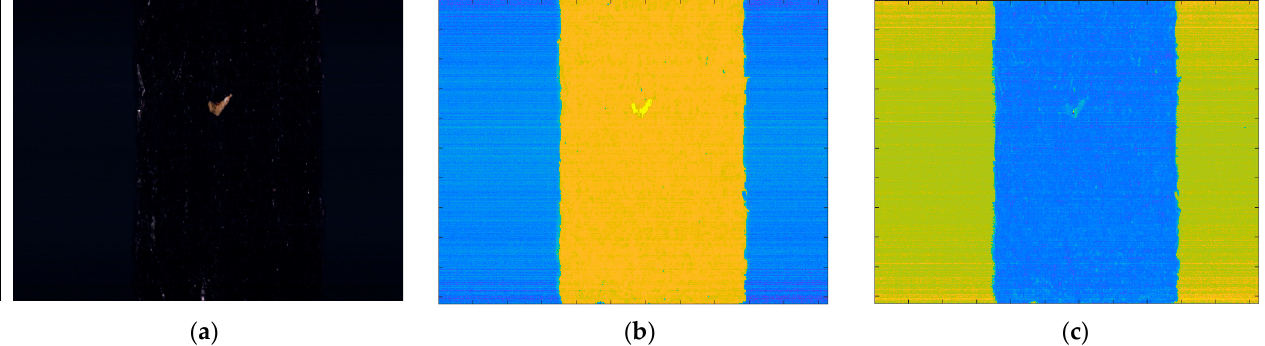
Figure 6. ( a ) Raw image, ( b ) Subtraction image in the visible range ( c ) Subtraction image in the near-infrared range.